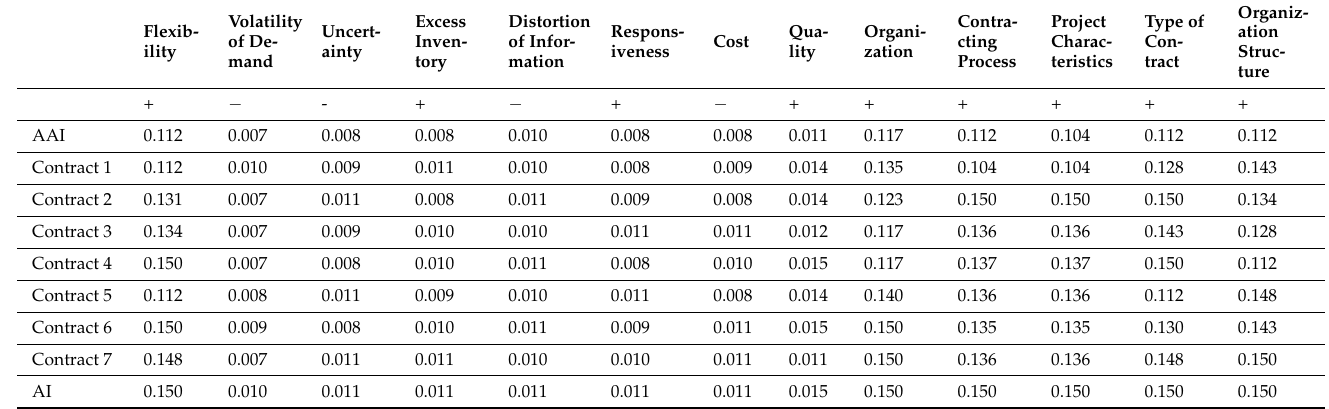
Table 14. Weighted decision matrix. + represents benefit criteria and – demonstrates cost criteria.